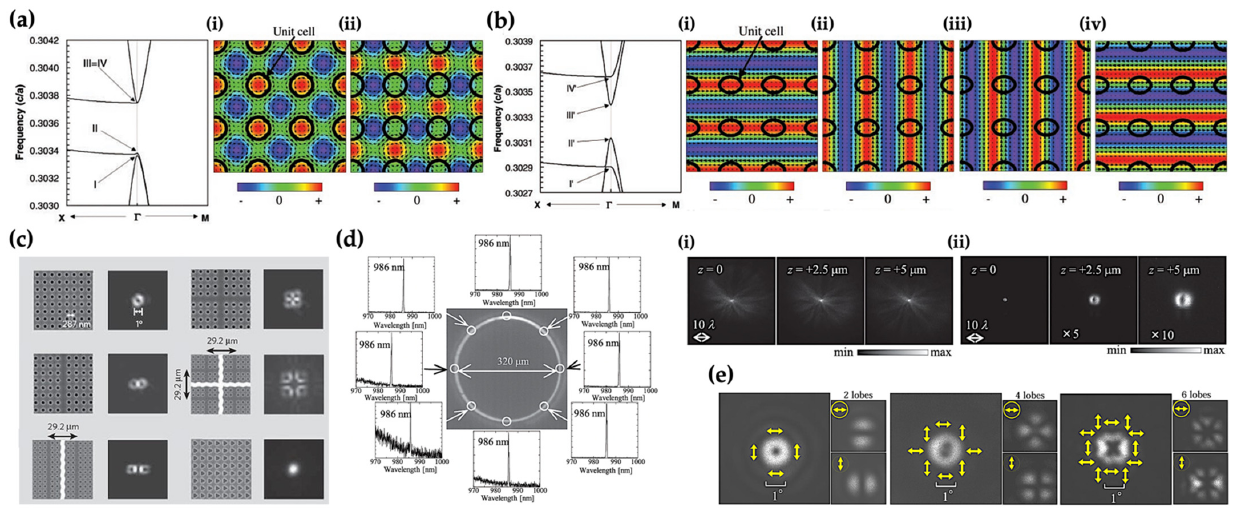
Figure 6. ( a ) Band structure of a 2D photonic crystal structure with square lattice and circular unit cell [44]. Insets: ( i,ii ) The corresponding electromagnetic field distributions at band edges I and II, respectively. Red and blue areas indicate the amplitudes of corresponding magnetic fields in the direction perpendicular to the plane. Arrows and thick black circles indicate the in-plane electric